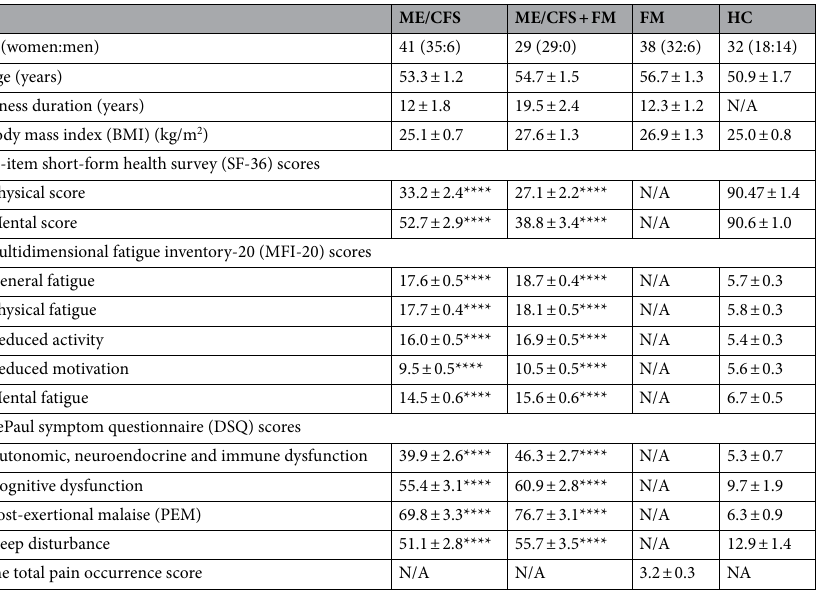
Table 1. Demographic and clinical characteristics of participants. The health self-reported questionnaires scores for different categories of SF-36, MFI-20, DSQ and the total pain occurrence score. All data are presented as mean and ± standard error of the mean. One-way ANOVA followed by Tukey’s multiple comparisons test were performed to determine the level of the significant difference between the different groups. The questionnaire scores were significantly different between ME/CFS vs. HC and ME/CFS + FM vs. HC. There was no significant difference between ME/CFS and ME/CFS + FM in this data. Results were considered significant at * P value < 0.05, ** P value < 0.01, *** P value < 0.001, **** P value <